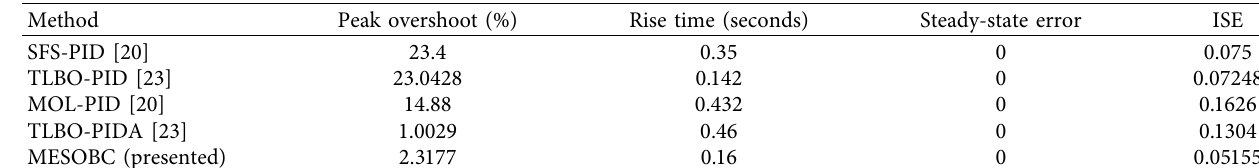
Table 2: Dynamic response specifcation of AVR with normal condition.